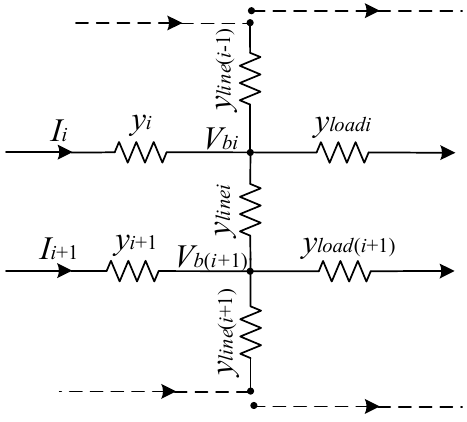
Figure 4. Network configuration.